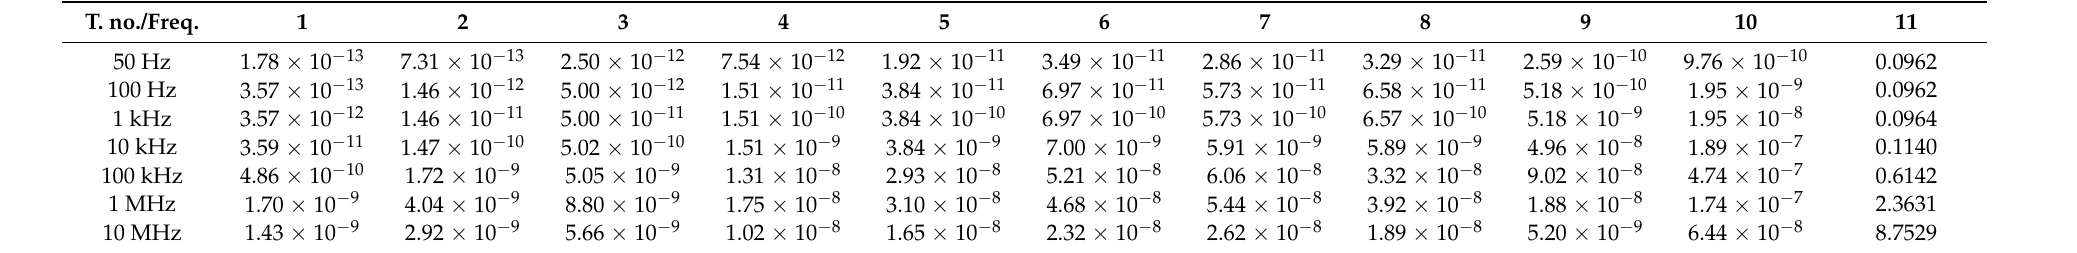
Table A20. Self and mutual resistances of turn 11 (in Ω ) resulting from FEM simulations. T.